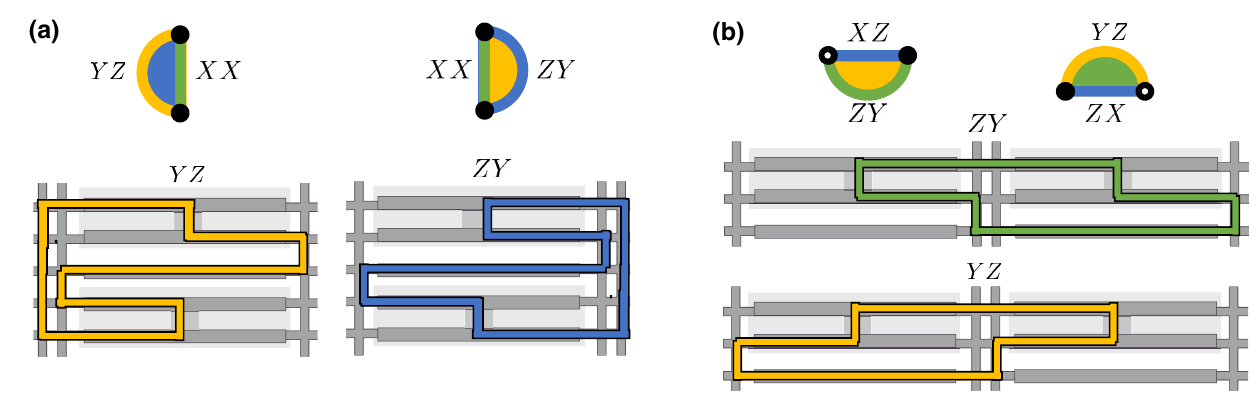
FIG. 6. The boundary measurements for the honeycomb Floquet code. (a) 2-gons along vertical boundaries require YZ or ZY between vertically adjacent qubit islands, which can be implemented using both semiconducting columns to the left or right of the qubit and the coherent link between the qubits. (b) 2-gons along horizontal boundaries require ZY and XZ or YZ and ZX measurements between horizontally adjacent qubit islands, which can be implemented using the coherent links above or below the qubit islands. As in Fig. 5, the white dot indicates that the roles of the X and Z operators are swapped for that qubit as compared to the bulk. Note that the XZ and ZX measurement loops are shown in Fig. 5.